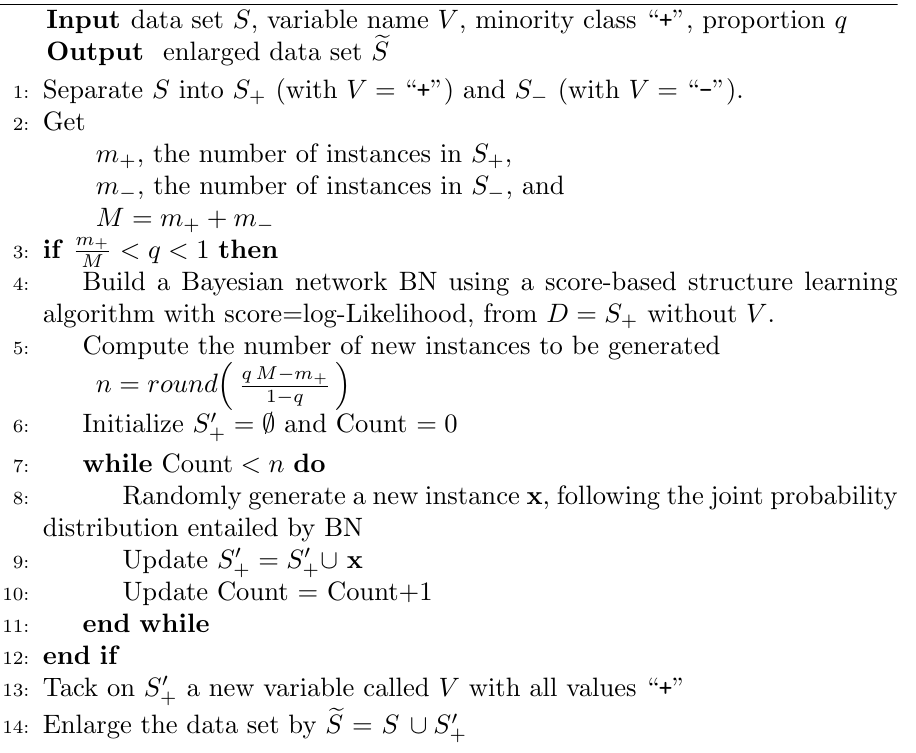
Algorithm 1 BOSME